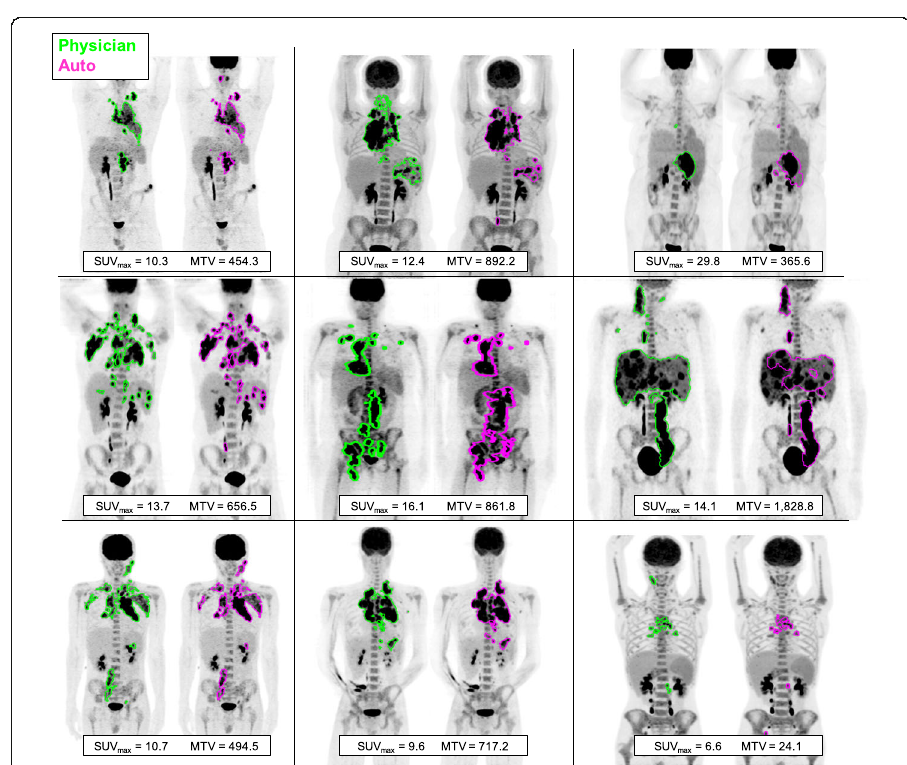
Fig. 4 Example segmentation results of the physician contours (green) and automated method (magenta). Two examples of outlier are shown in the middle row: one for which MTV was largely overestimated (middle row, middle column) and one for which widespread liver disease was missed (middle row, right column). Units for SUV max are in g/ml, and for MTV are in cm 3 , and values were extracted from physician